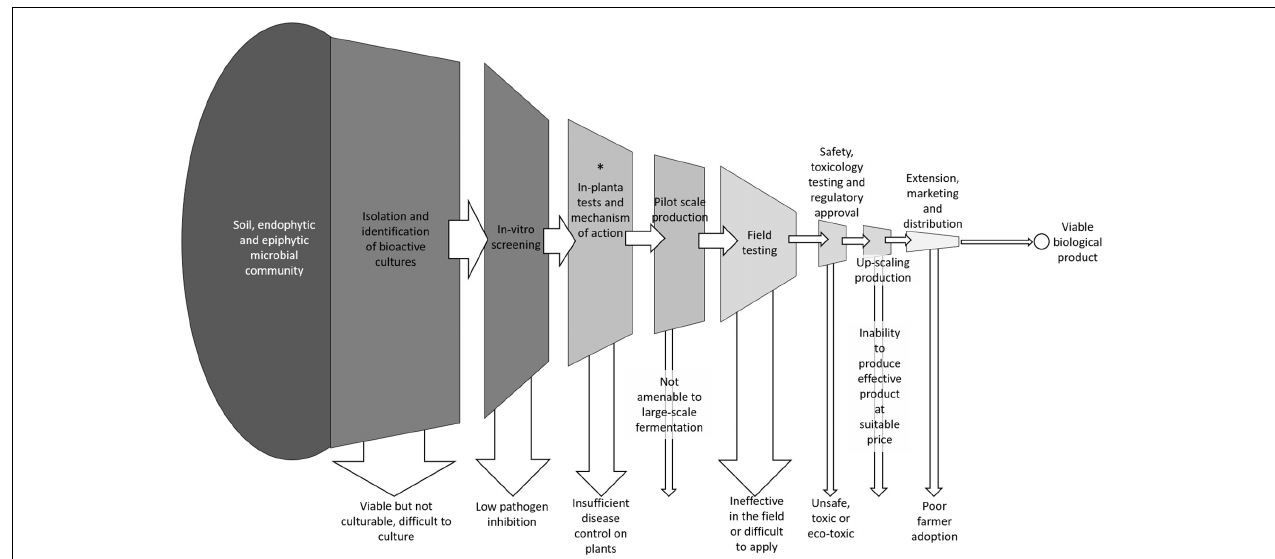
FIGURE 10 | Conceptual diagram of the steps involved in bringing a new biological disease control to the market including the common ways that isolates fail along the pipeline. * Indicates the approximate stage in this pipeline that the two most successful isolates from this study have made it